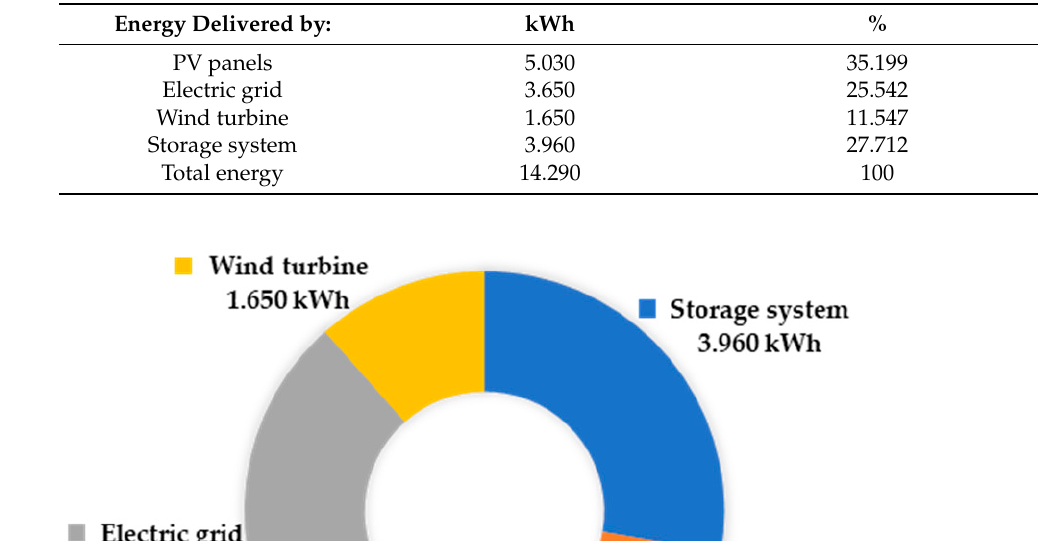
Table 3. The amount of energy used for consumption—second scenario.